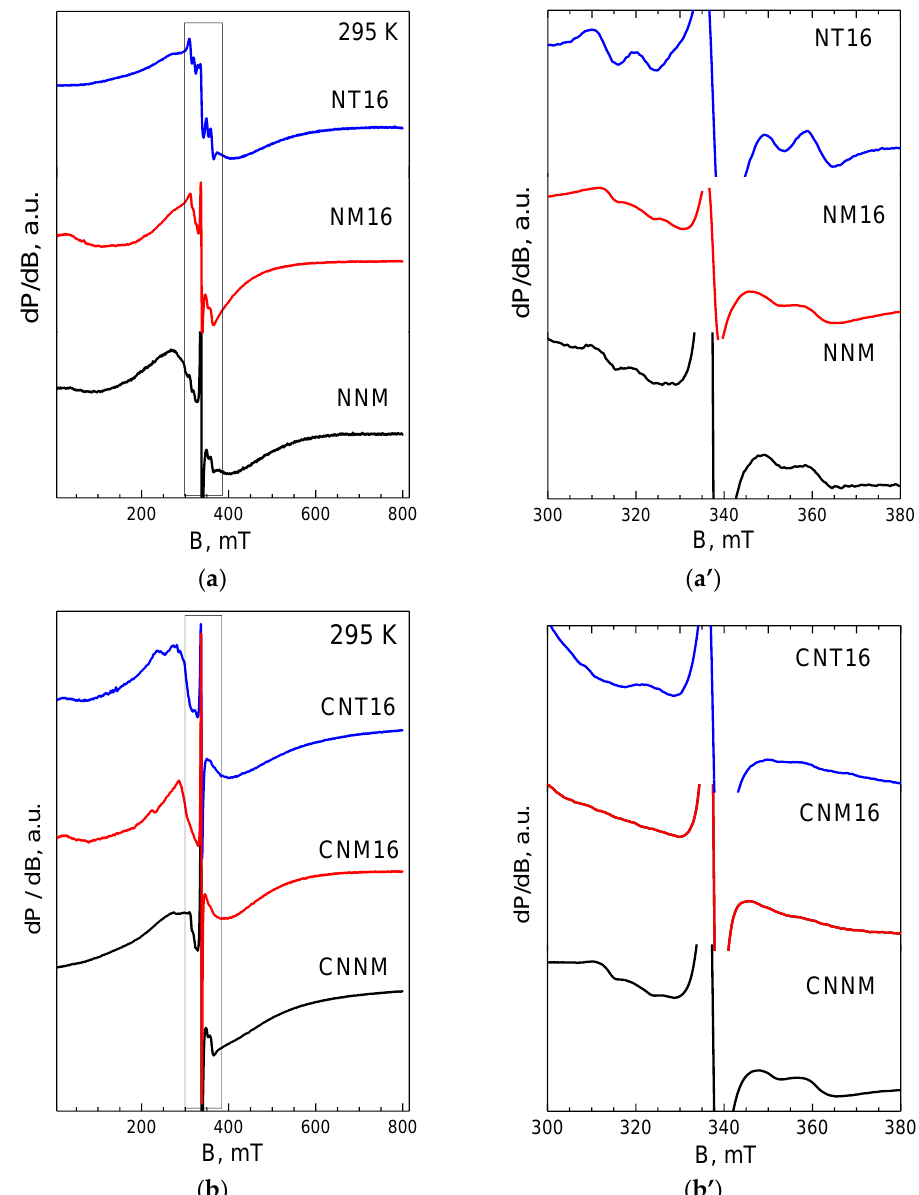
Figure 9. EPR spectra of metal-substituted oxides ( a ) and CeO 2 -treated analogues ( b ) after cycling in sodium-ion cells between 1.5 and 4.5 V for 40 times (the cell is switched off at 1.5 V). The parts of the spectra in the narrow range of the magnetic field (i.e., between 300 and 380 mT) are also shown ( a’ , b’ ).